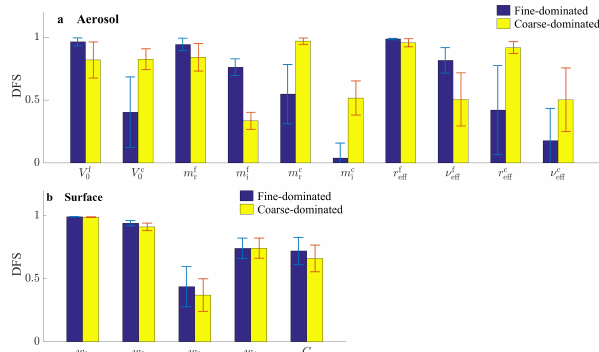
Figure 3. The mean and standard deviation of the each DFS component of aerosol (a) and surface parameters (b) presented in the format of a histogram with error bars.